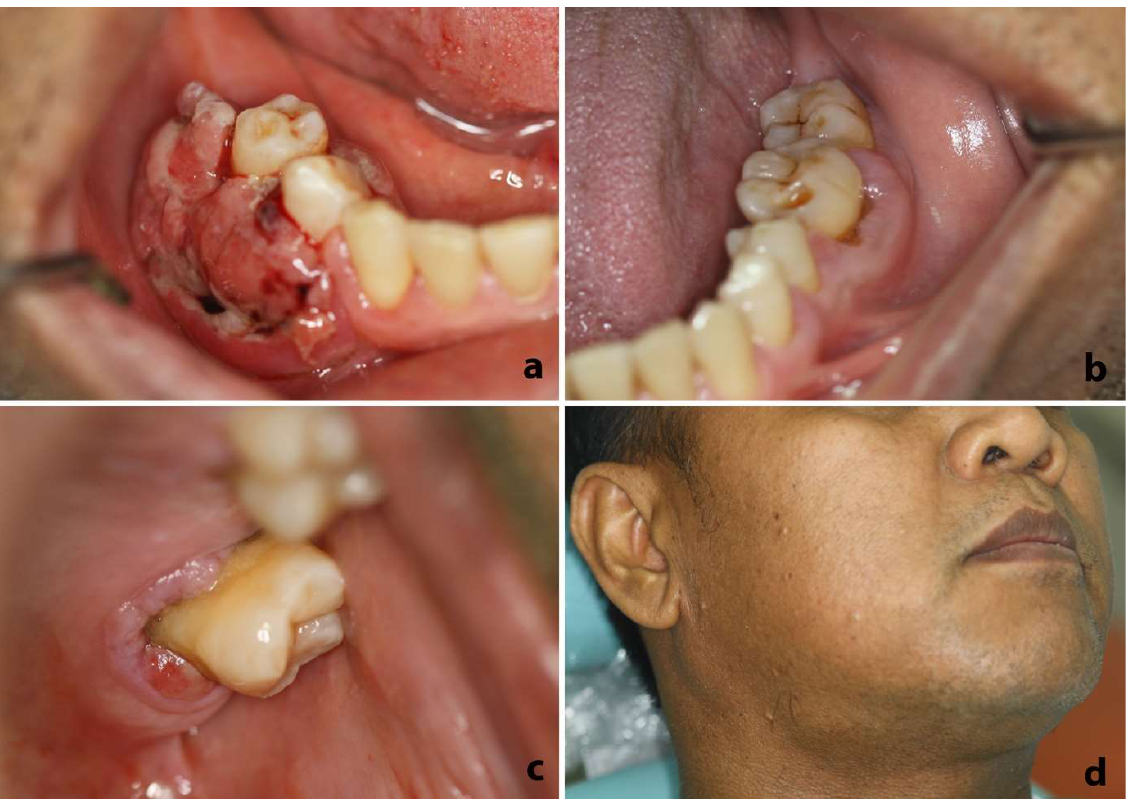
Figure 1. ( a – c ) Intraoral clinical examination showing ( a ) exophytic, hemorrhagic ulcerated mass surrounding the gingiva of the right mandibular premolars extending posteriorly to the edentulous alveolar mucosa, ( b ) gingival enlargement in the left posterior mandibular buccal gingiva, and ( c ) gingival enlargement in left posterior maxillary palatal gingiva. ( d ) Extraoral clinical examination demonstrating an enlarged lymph node in the right submandibular area.